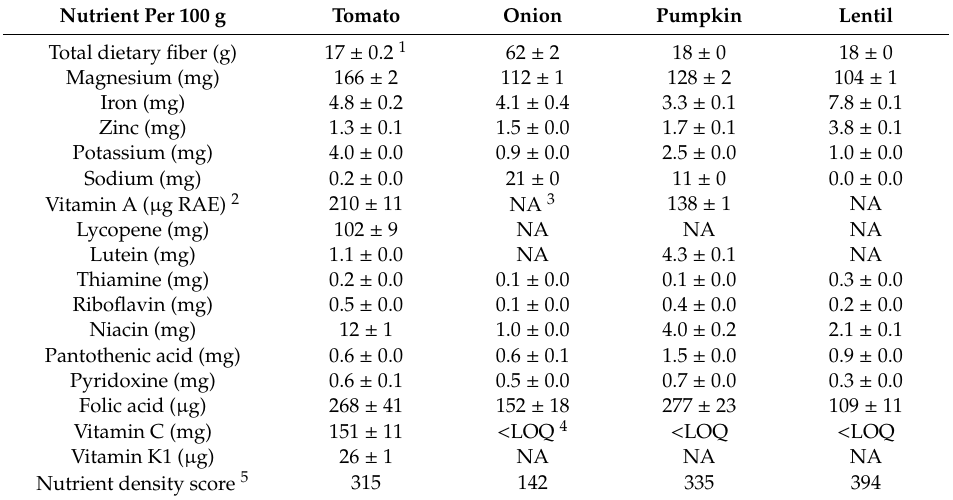
Table 1. Mean nutrient content of dry vegetable